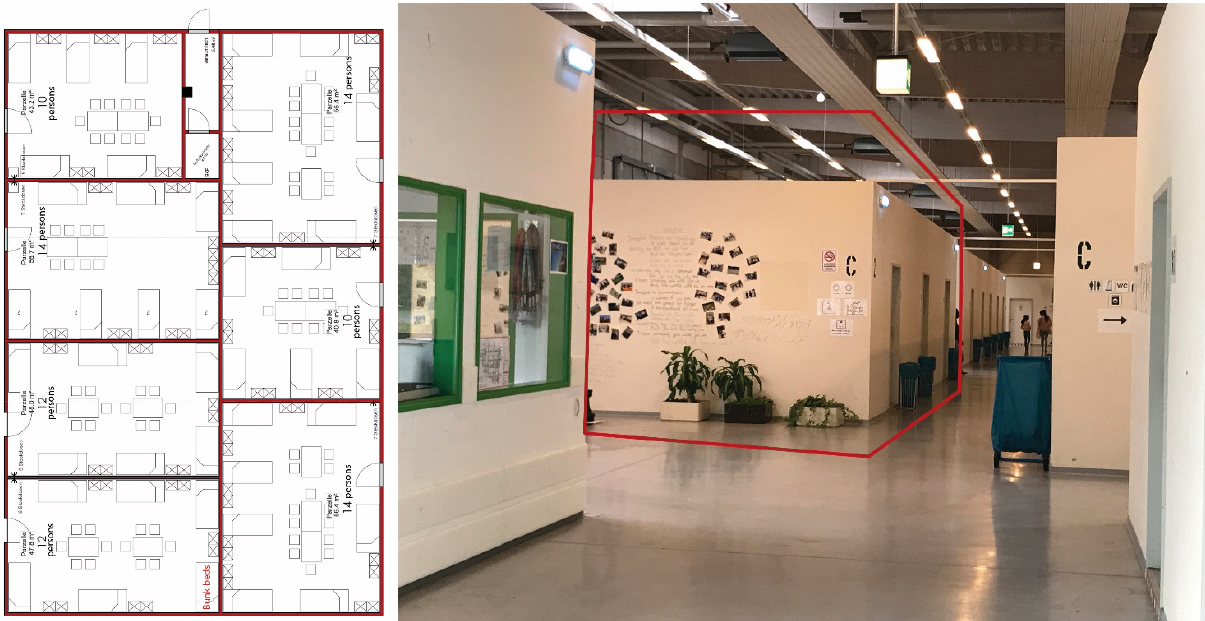
Figure 7. Right: interior of accommodation hall with its partitioned blocks. Left: floor plan of one block, as marked on the right. The partitions (rooms) accommodate between ten and 14 persons. Sources: author (right); edited from a floor plan published in the Göttingen City website in 2017